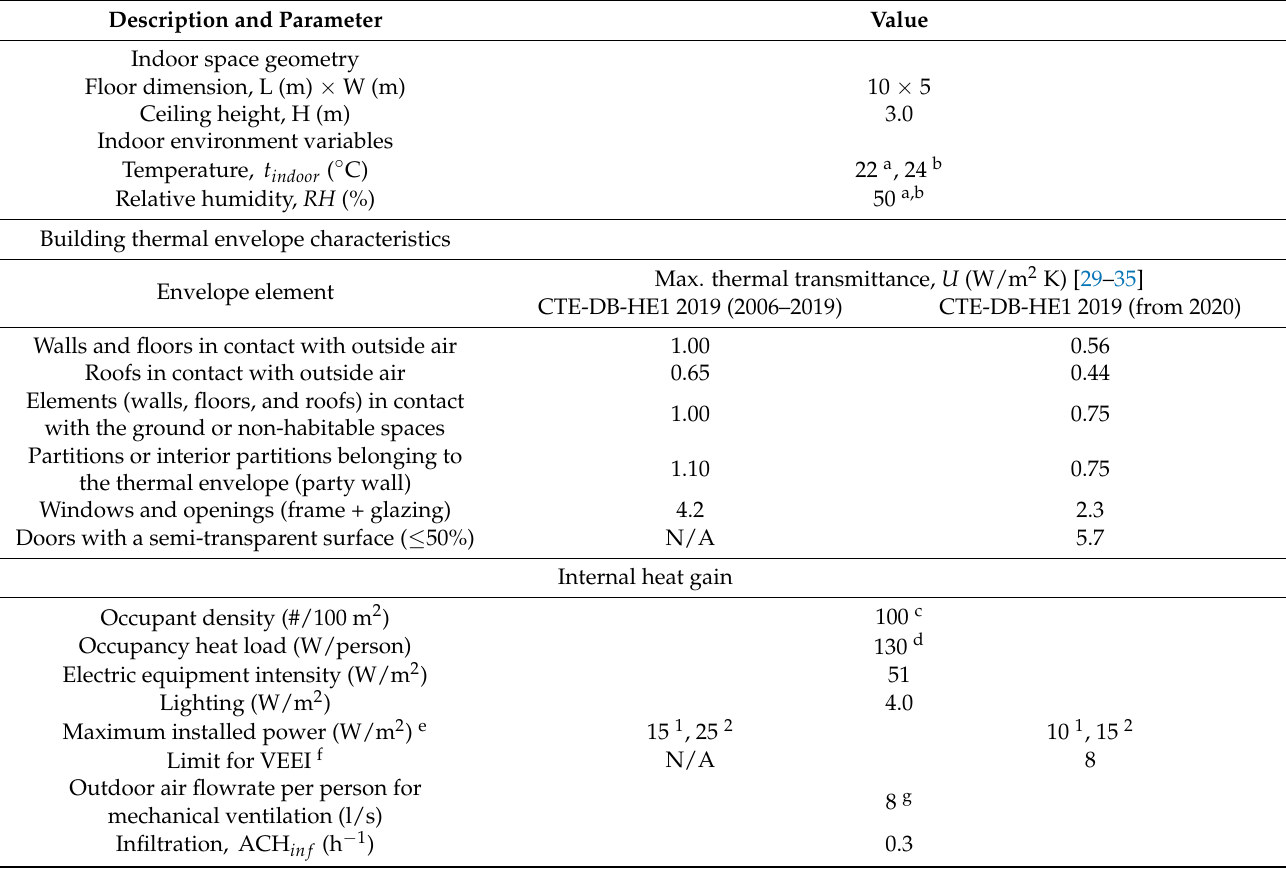
Table 1. Building envelope, space geometry, internal heat loads, outdoor air flow rate for mechanical ventilation, and other input modelling parameters for the selected indoor